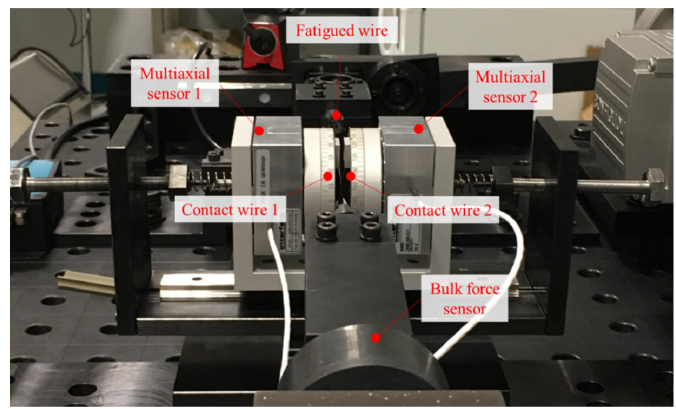
Figure 5. The contact module for fretting fatigue configuration.